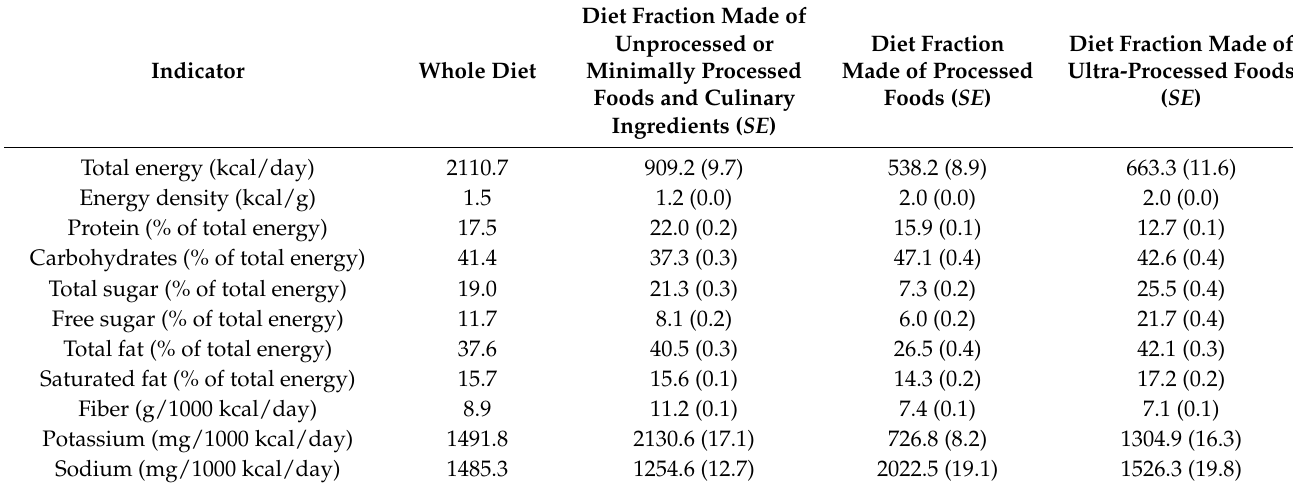
Table 4. Nutrient profile of the whole diet and of three diet fractions. French population ≥ 18 years. ENNS 2006 ( n = 2642). Indicator Whole Diet